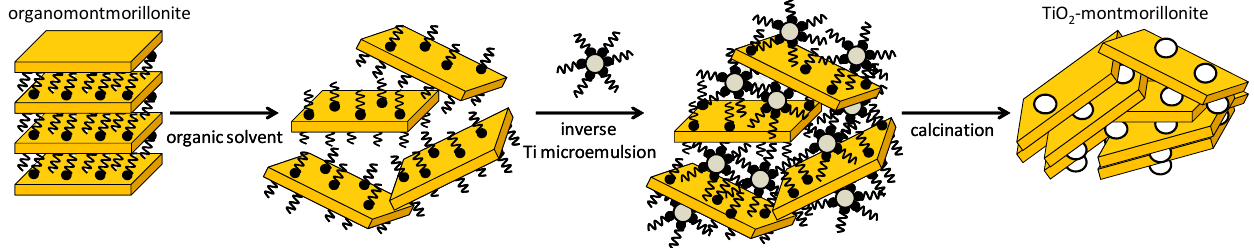
Figure 8. Schematic illustration of the use of inverse Ti microemulsion for the preparation of TiO 2 –montmorillonite com- posite.